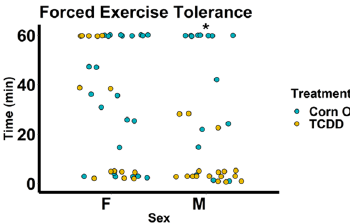
Figure 4. Forced exercise tolerance after TCDD exposure in mice from E0.5 through 12 months of age. The mice were run at 14 m/min for 60 min and the shock strength was set to 2.0 mA. Shocks were only counted when one of the following criteria were met: the mouse fell onto the shock bars, any part of the mouse touched the metal shock bars (exception: the mouse’s tail) or the mouse noticeably jumped from the shock. Failure was defined as the mouse can no longer run, the mouse does not respond to a shock or the mouse has reached a total of 50 shocks for the day. After failure, a mouse was immediately returned to its cage. Each dot represents an individual mouse. * p < 0.05 as measured by two-sided Mann–Whitney U test for a specific sex. Corn oil: n = 23 females, 16 males; TCDD: n = 14 females, 17 males. One male mouse was excluded due to inability to respond to shocks during acclimatization.